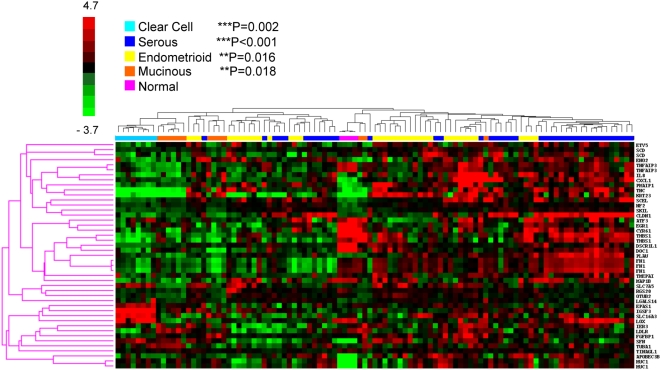
39-gene transcriptional signature clusters serous EOC samples from patient-derived gene expression data.Datasets were downloaded from the NCBI Entrez GEO DataSets website and analyzed for gene expression changes among all included transcripts in the 39-gene signature. Median values of transcripts contained in the LPA gene signature were clustered and average linkages were calculated using the Cluster software. Results were visualized using the TreeView program (see methods). GSE6008, N = 103. The strongly-positive LPA cluster, N = 19, (mostly red) is seen in the bracket on the far right corresponding to serous tumors. Statistical analysis compared normal control samples with ovarian tumor samples of the types indicated and used ANOVA and Tukey's Multiple comparison post test; **P<0.05, **P<0.01 and ***P<0.001.